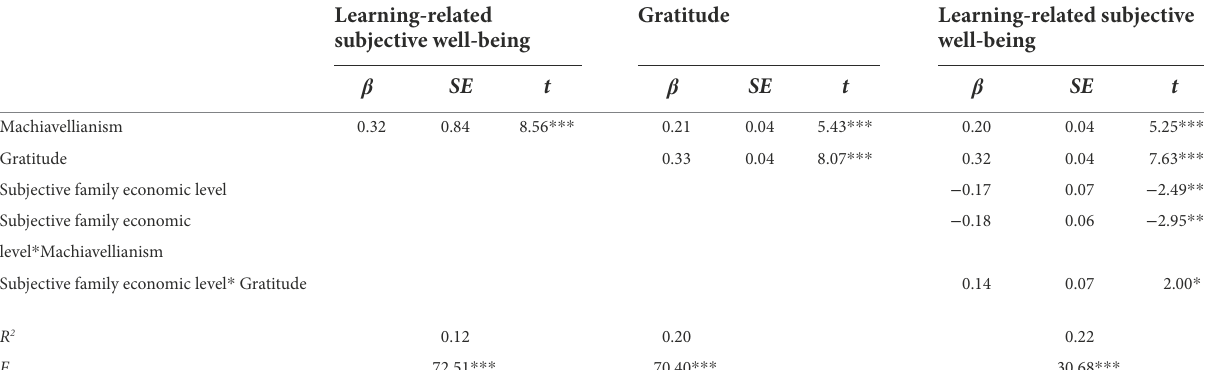
TABLE 3 Test the moderated mediation